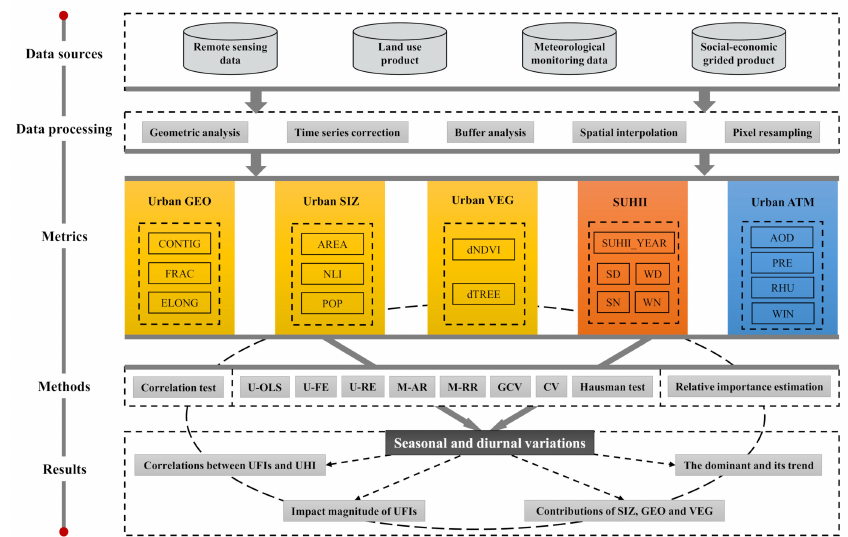
Figure 3. Overview of the data processing and modeling framework. (Note: SD, WD, SN, and WN represent summer day, winter day, summer night, and winter night, respectively; U- and M- represent the univariate and multivariate models, respectively; FE, RE, AR, and RR are statistical models described in Section 2.3; GCV is a generalized cross-validation method; CV is cross-validation.).